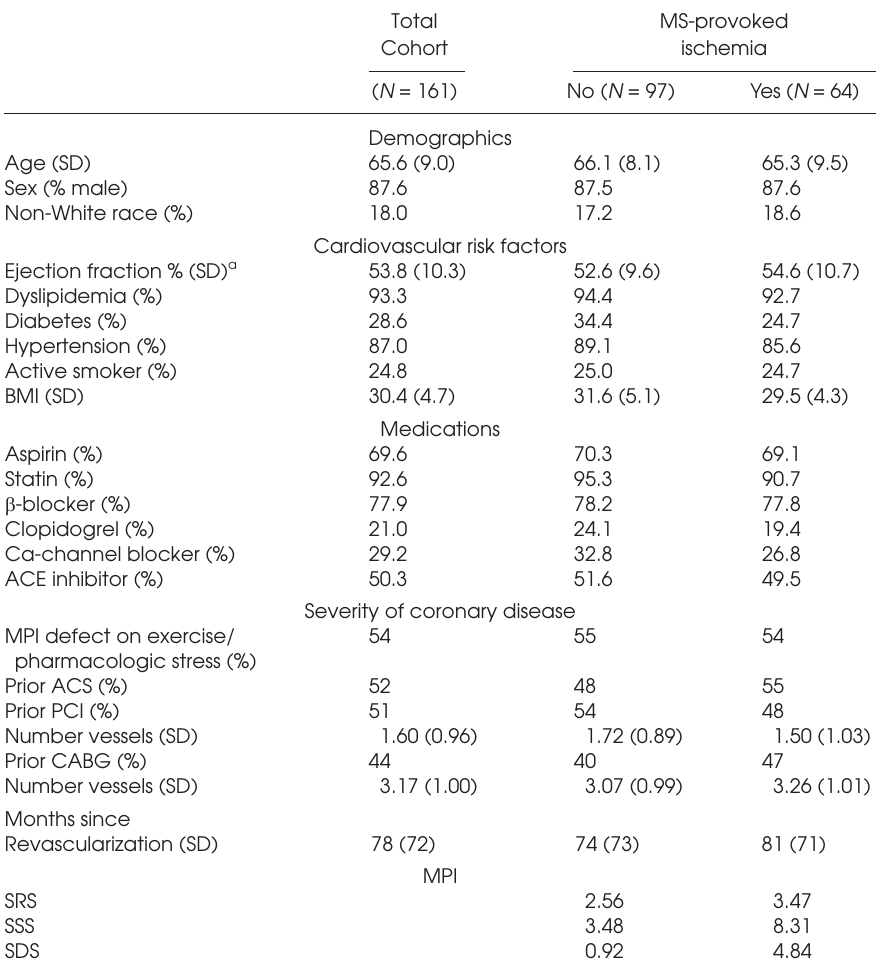
Table 1. Patient characteristics.